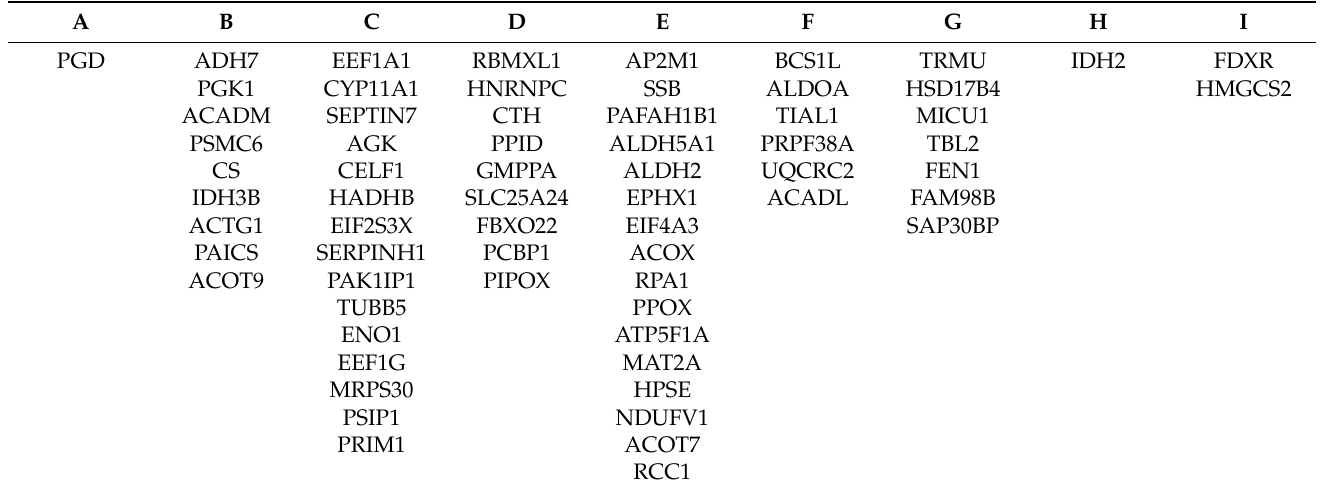
Table 6. Proteins from Sample 2 present in the different categories from Figure 5B.